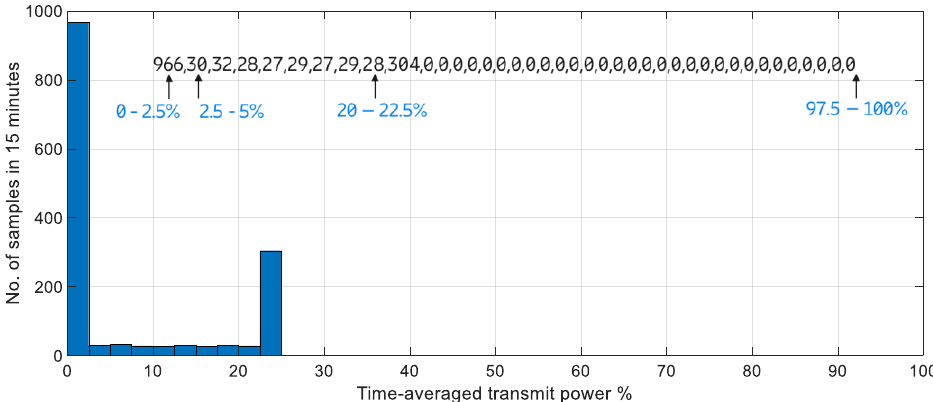
Figure 1. Example of a six-minute time-averaged transmit power distribution (normalized) for a BS over a fifteen-minute interval. Each bar shows the number of samples falling into a specific range of values (100% would correspond to the BS operating at the maximum available power continuously for 6 minutes). The overlaying text represents the raw data as collected from the ENM, i.e., indicating that 966 samples of P avg belonged to the 0–2.5% interval, 30 to 2.5–5%, 32 to 5–7.5%...304 to 22.5–25%. No samples in the example were obtained above the 22.5–25% interval.